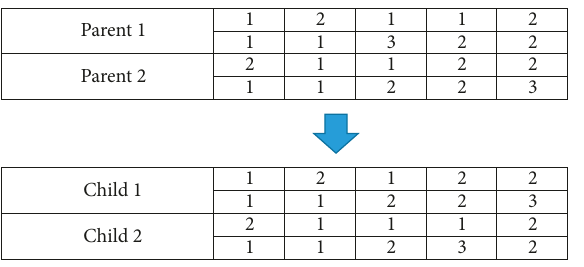
Figure 2: An example of the crossover operator.